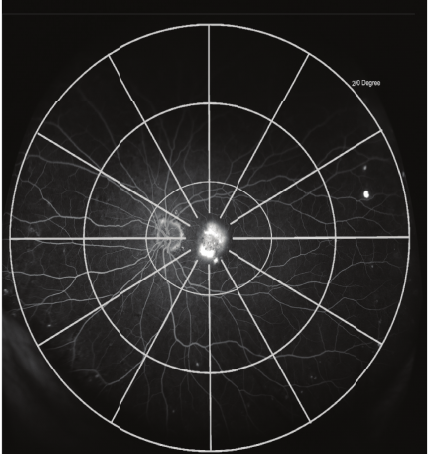
Figure 1: Grid superimposed on wide-field fluorescein angiogram image to show zones 1 ( < 50 ∘ ), 2 (50–100 ∘ ), and 3 (100–200 ∘ ) centred on the